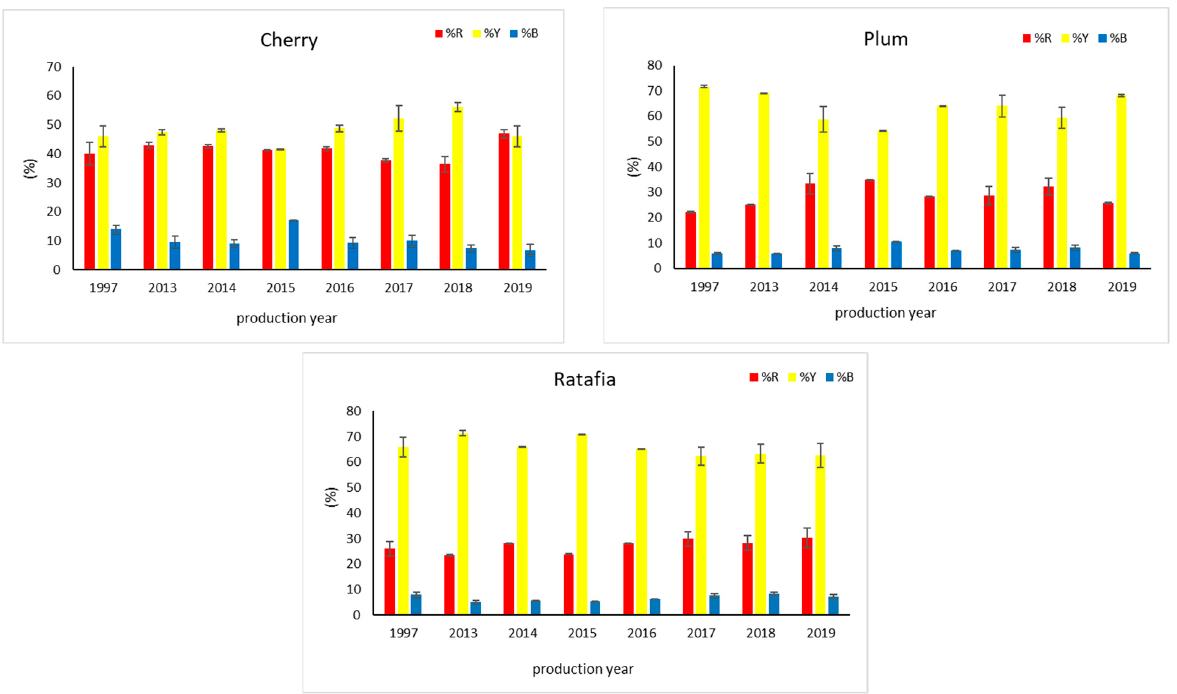
Figure 2. The color parameters of three nalewkas produced in different years (mean ± SD, n = 3). %R — the percentage of red color, %Y — the percentage of yellow color, %B — the percentage of blue color.